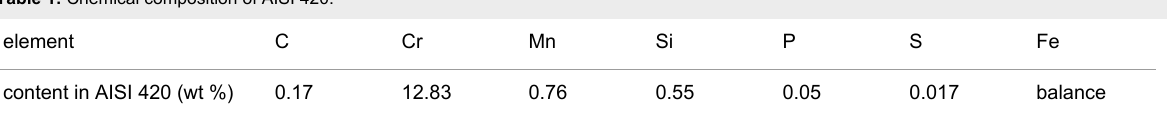
Table 1: Chemical composition of AISI 420.